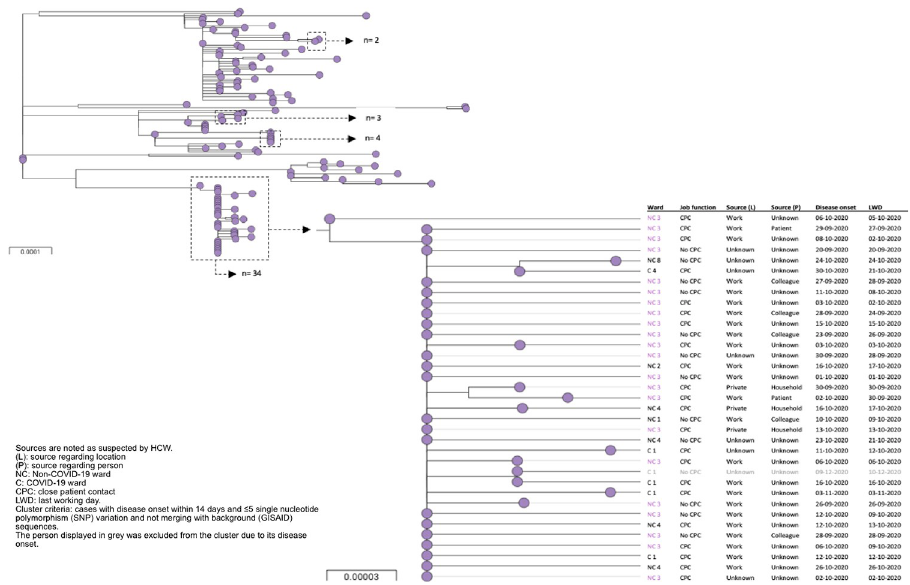
Fig 1. Phylogenetic tree of study population (n = 123) with four clusters indicated. The largest cluster is paired with additional information.